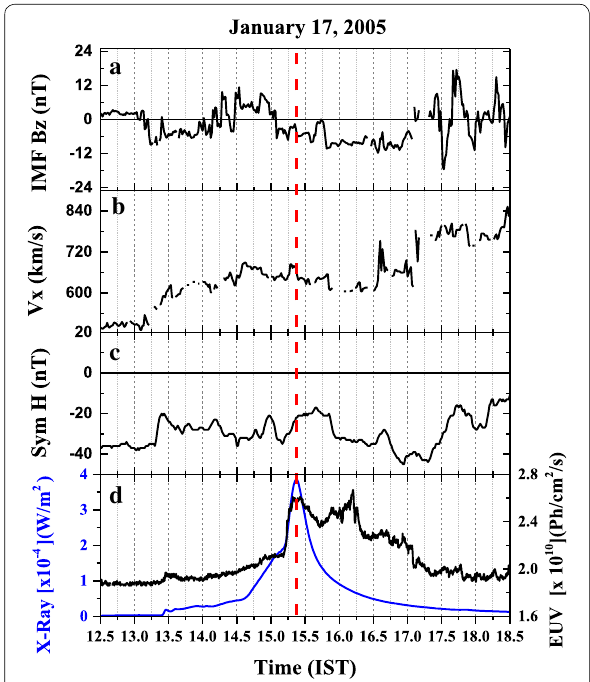
Fig. 5 The time variations of a interplanetary magnetic field (IMF Bz), b solar wind speed (Vx), c Sym-H along with, d flare radiations on January 17, 2005. The flare peak time is marked using the vertical dotted